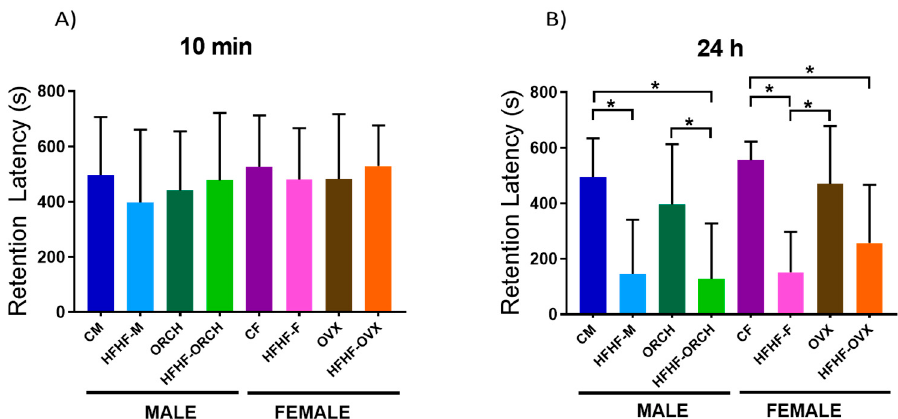
Figure 4. Effect of HFHF diet on short- and long-term memory. ( A ) Retention latency in short-term memory (10 min) of all studied groups. ( B ) Retention latency in the long-term memory (24 h) was observed to decline in the latency of the HFHF-M, HFHF-ORCH, and HFHF-F groups vs. their peers. CM: control males, HFHF-M: metabolic syndrome males, ORCH: males with orchidectomy, HFHF-ORCH: metabolic syndrome males with orchidectomy, CF: control females, HFHF-F: metabolic syndrome females, OVX: females with ovariectomy, and HFHF-OVX: metabolic syndrome females with ovariectomy. The data represent the mean ± SD. Evidence of 3-way ANOVA with post hoc Tukey test. * p < 0.05. Retention Latency 24 h: main effect of diet exposure [F (1, 72) = 49.08, p < 0.0001].